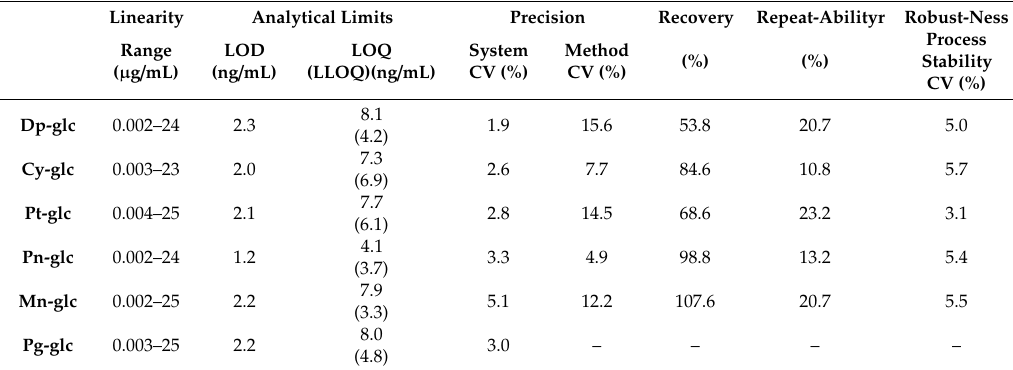
Table 4. Validation parameters of anthocyanins in